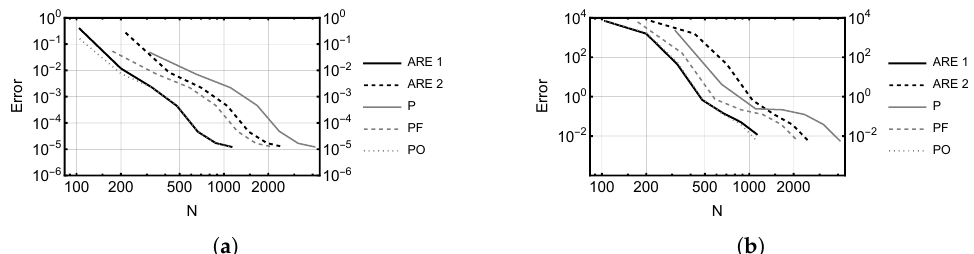
Figure 11. ARE convergence of Pitkäranta cylinder, t = 1/100. Squared energy norm convergence (absolute error) in p = 2, . . . ,8 using different discretisations: ARE 1: one layer, ARE 2: two layers, P: full tensor product grid with two layers, PF: full tensor product grid with one layer, PO: minimal full tensor product grid conforming to ARE 1. The observed convergence of the proposed method in both test cases agrees with the standard p -version. N is the number of degrees of freedom. ( a ) Clamped case. ( b ) Free boundary.